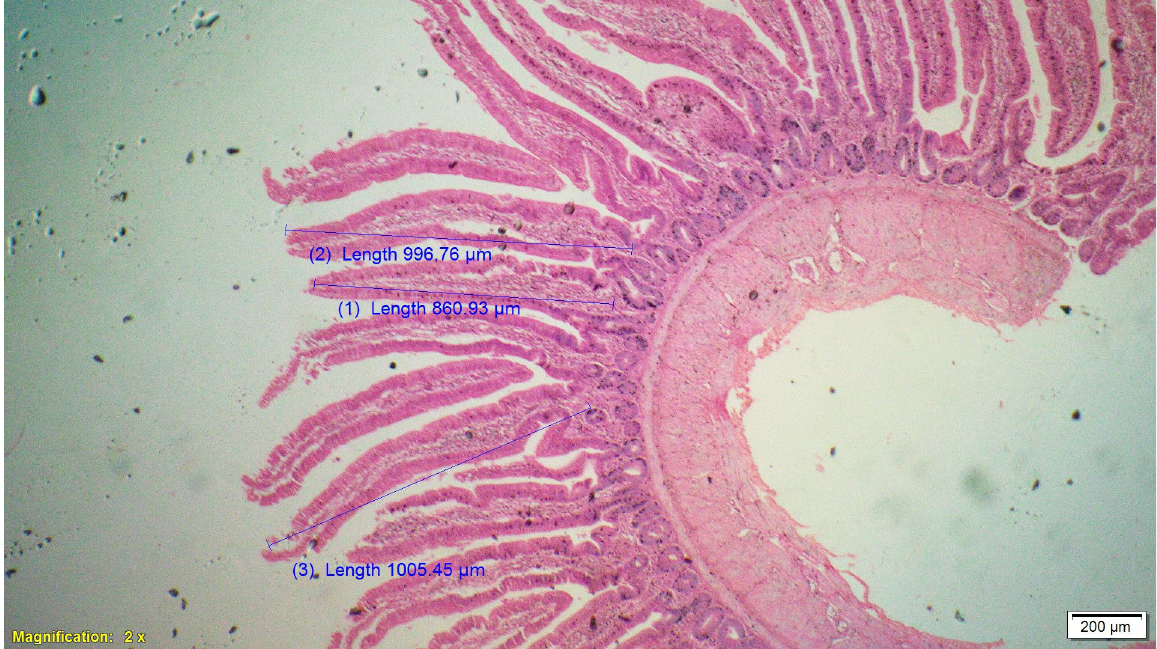
Fig 2. Photomicrograph of the cross section of Jejunum from antibiotic group (T2). H&E, 2x.